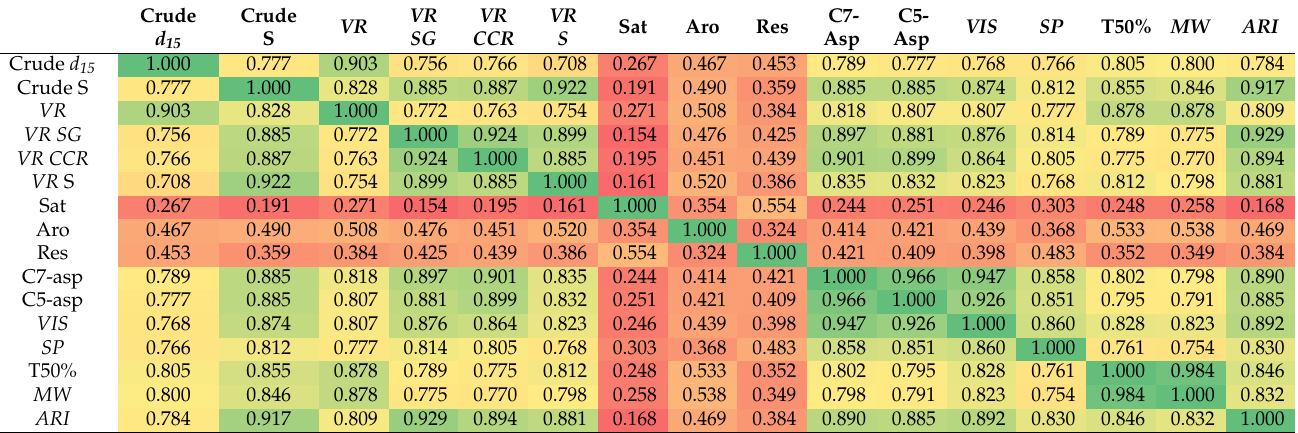
Table 5. The µ -values for the ICrA evaluation of relations between properties of the studied SRVR